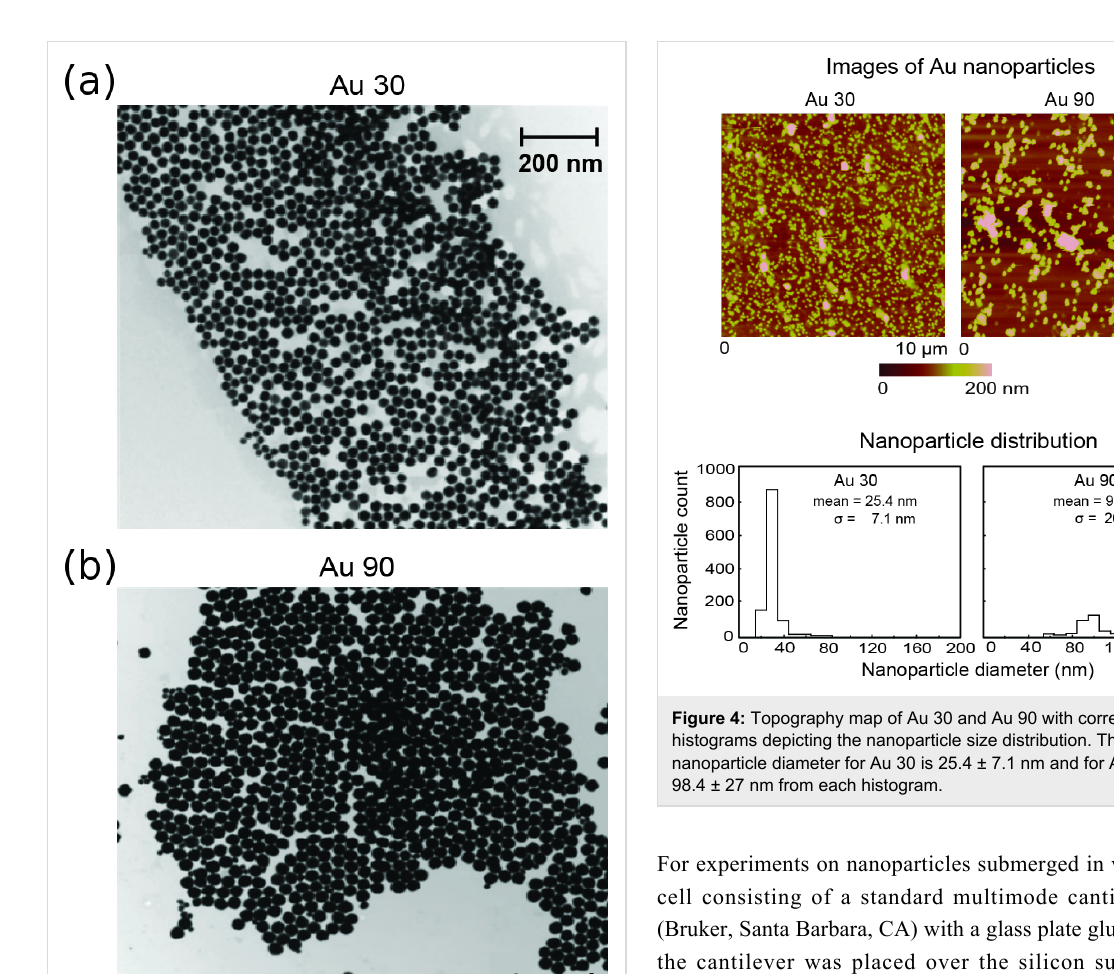
was used for all sliding and wear experiments unless otherwise stated. The substrate was then placed on a hot plate and heated to a temperature of about 70–80 °C and left until the water evaporated. The nominal diameters for the Au nanoparticles as reported by the manufacturer were about 30 and 90 nm, to be henceforth referred to as Au 30 and Au 90, respectively.